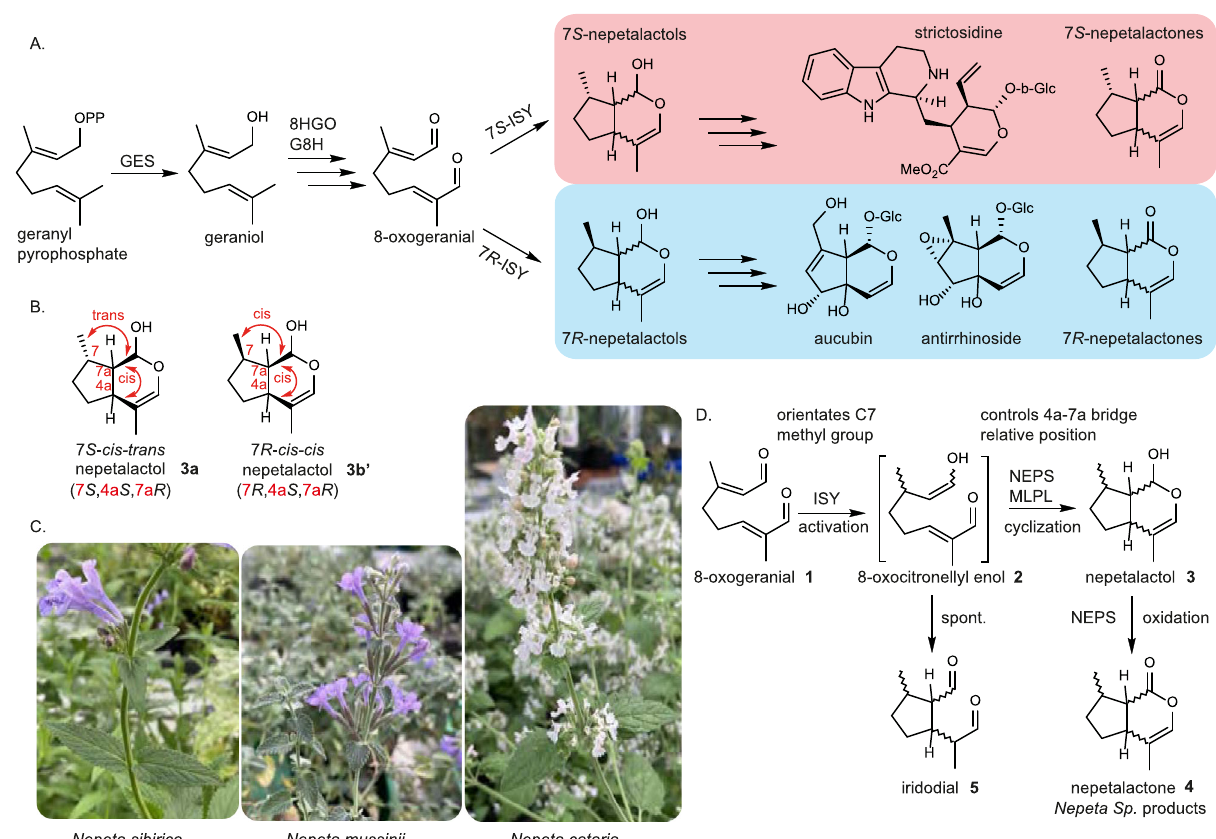
Fig. 1 | Overview of the nepetalactol scaffold and its stereo-control in the Nepeta species.A Theearlyiridoidpathwaytakestwomaindirectionsbasedonthe preferred stereochemistry of iridoid synthase (ISY). 7S- ISY leads to biosynthesis productssuchas(7 S )nepetalactonesfoundinmost Nepeta species,aswellaswell- known indole alkaloid precursor strictosidine in C. roseus and other species (red). 7R- ISY exists in other members of the Asterids clade, particularly the Lamiales order, where iridoid glucosides with this C7 stereochemistry is common (light blue). B Nepetalactol 3 stereochemistrycanadopt8stereo-chemicalcon fi gurations based on the relative positions of the C7 methyl group and the 7a-4a bridge.